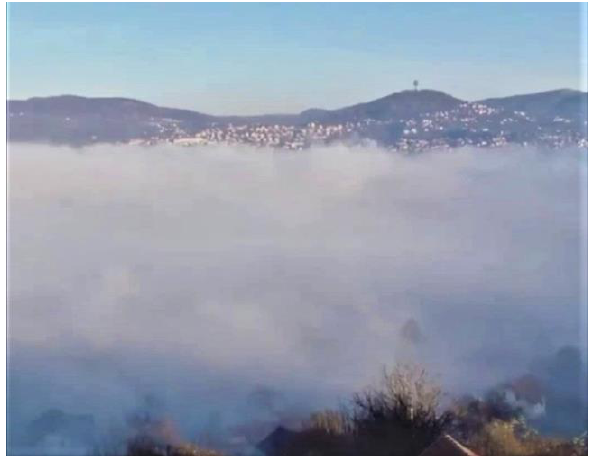
Figure 1 . Sarajevo under smog during the winter months.